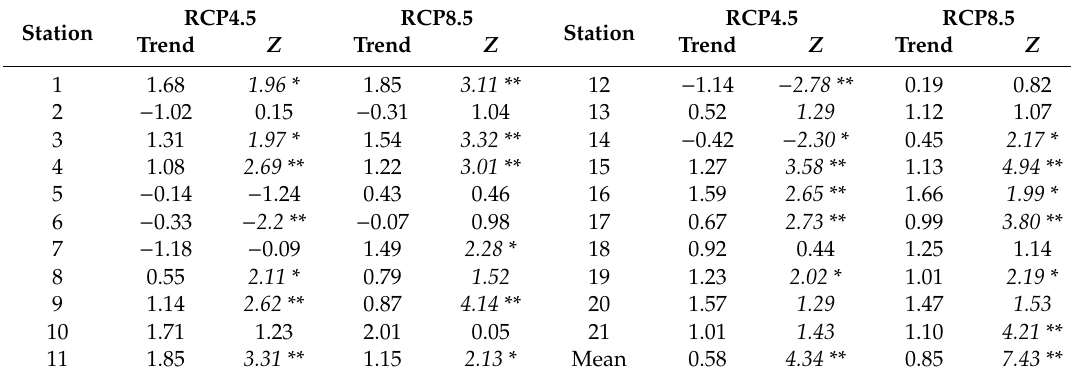
Table 9. The changing trend (mm / year) and values of Z for yearly precipitation series in the period of 2006–2095 for each station and region mean. RCP4.5 RCP8.5 RCP4.5 RCP8.5 Station Station Trend Z Trend Z Trend Z Trend